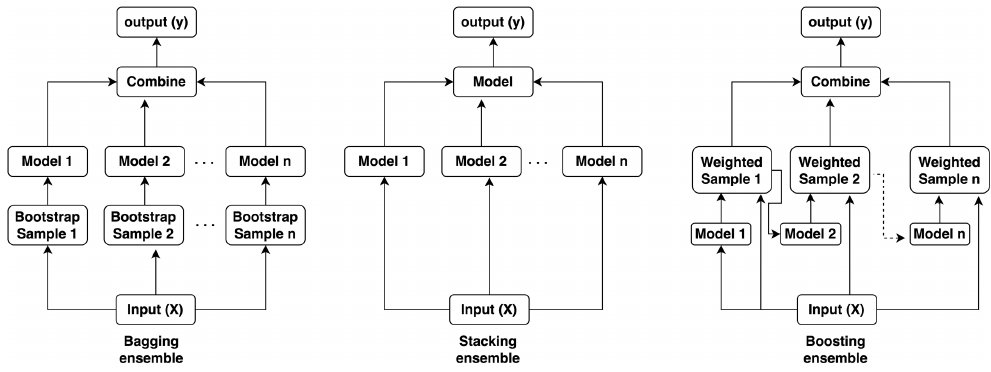
Figure 3. Different ensemble methods.